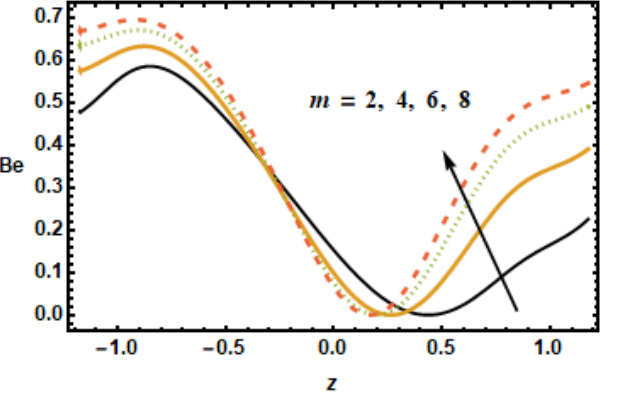
M on Be . M on Be .